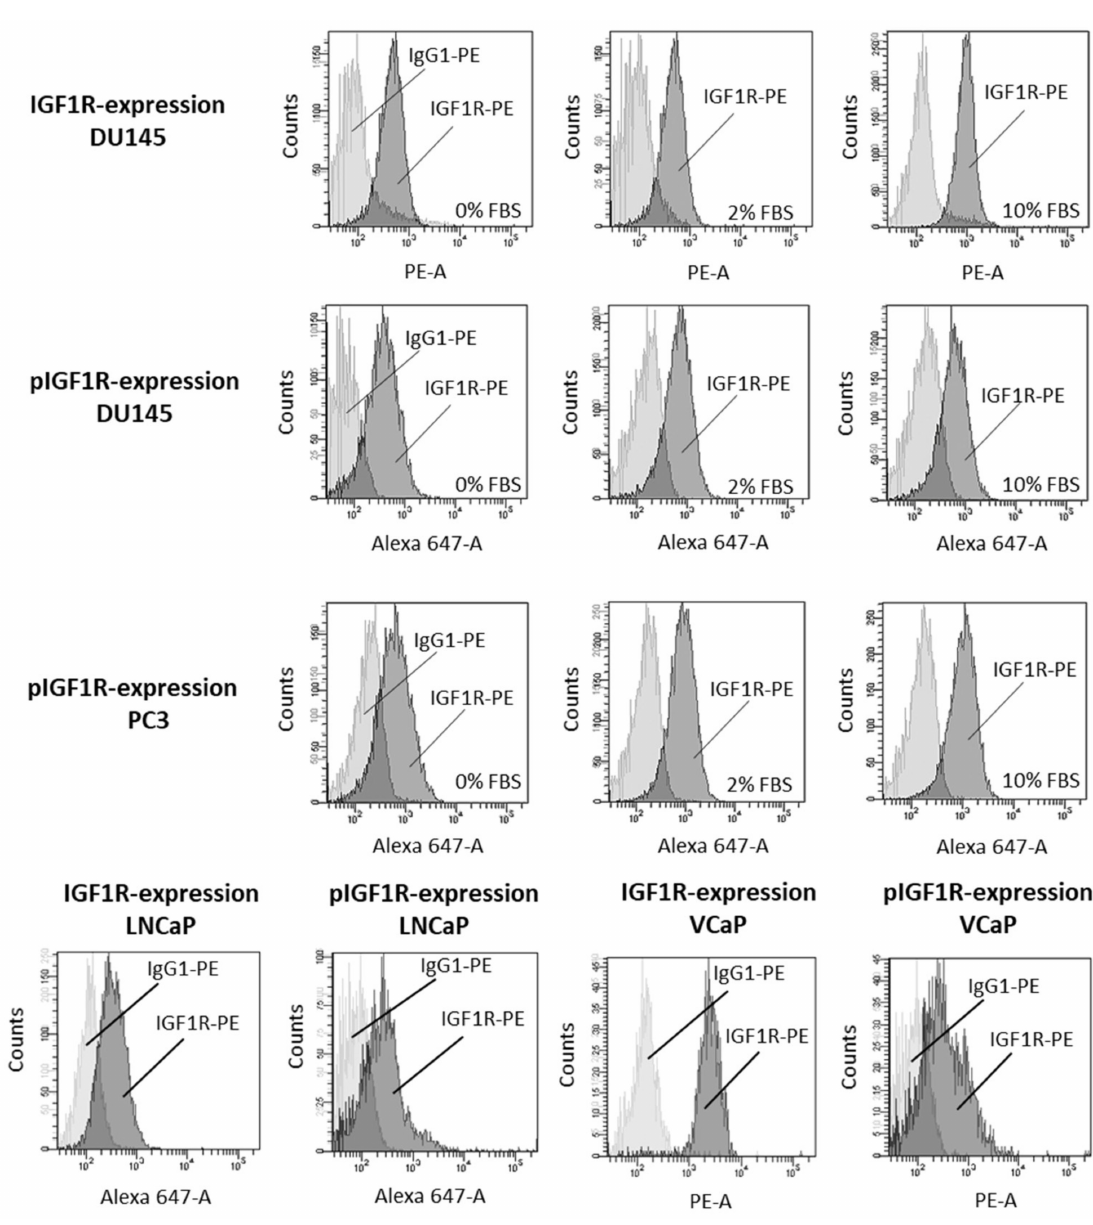
Figure 1. IGF-1R (IGF1R) and pIGF-1R (pIGF1R) expression levels in DU145, PC3, LNCaP and VCaP cells. Light gray: isotype control; dark gray: specific fluorescence. Flow cytometry curves are representative for one of three